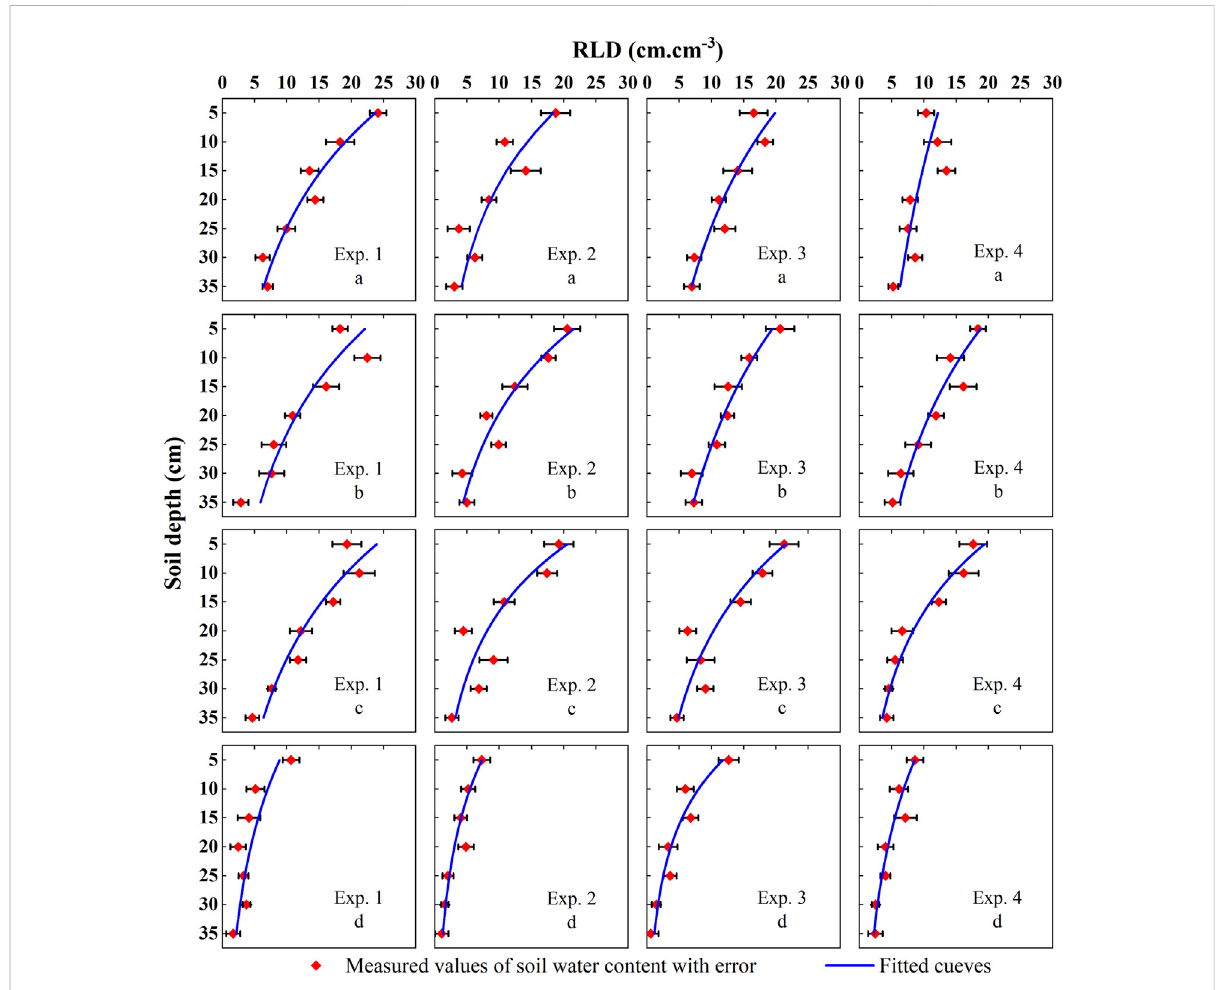
FIGURE 3 Distribution characteristics of root length density on the soil pro fi le and the fi tted curve based on Eq.